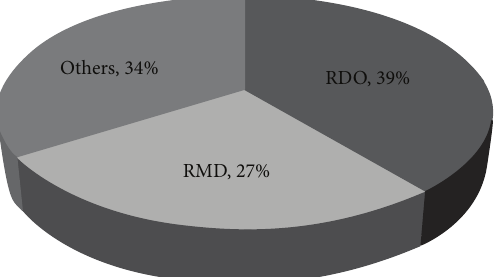
Figure 4: The possibility of being selected as the optimal prediction mode for RMD and